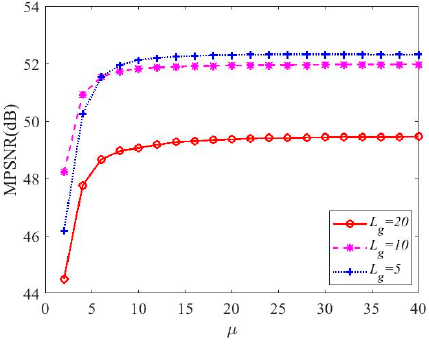
Figure 3. Sensitivity analysis of the regularization parameters ff erent number of bands in each group L algorithm with different number of bands in each group SR = 0.0564, ( b ) L g = 10, SR = 0.1048, and ( c ) L g = 5, SR = 0.2048.